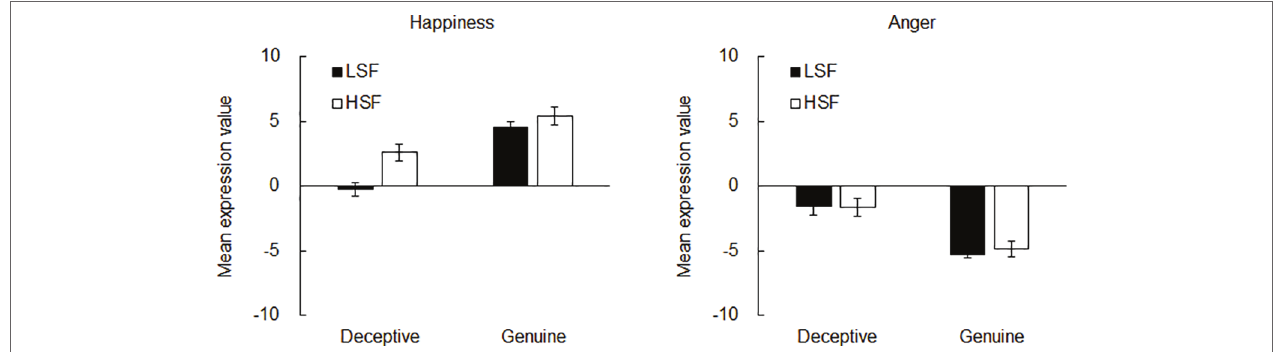
FIGURE 2 | Results of Experiment 1. Mean expression value of the deceptive and genuine images created for each frequency in the happiness (left panel) and anger (right panel) conditions. Error bars indicate standard errors of the